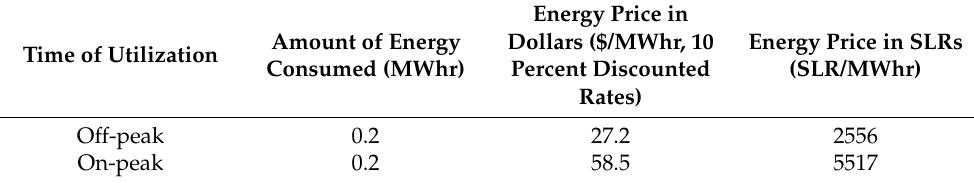
Table 3. Implemented price mechanism in a blockchain.